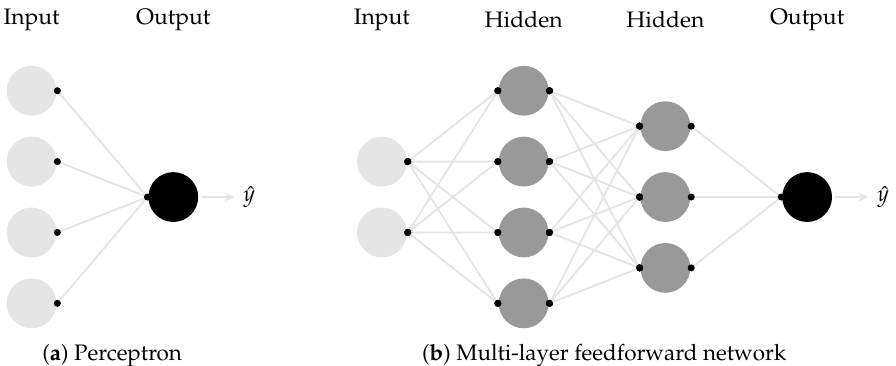
Figure A1. Basic architectures of ( a ) the perceptron and ( b ) a multi-layer feedforward